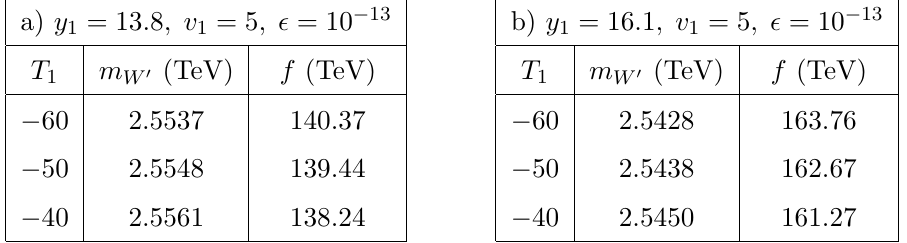
Table 2. The mass of the lightest KK mode of the W boson and the radion VEV for two benchmark parameter sets, with (cid:11) =1. The tuning v 0 =v 1 , for T 1 = -60, -50 and -40 is 0.46, 0.53 and 0.62 respectively for both a) and